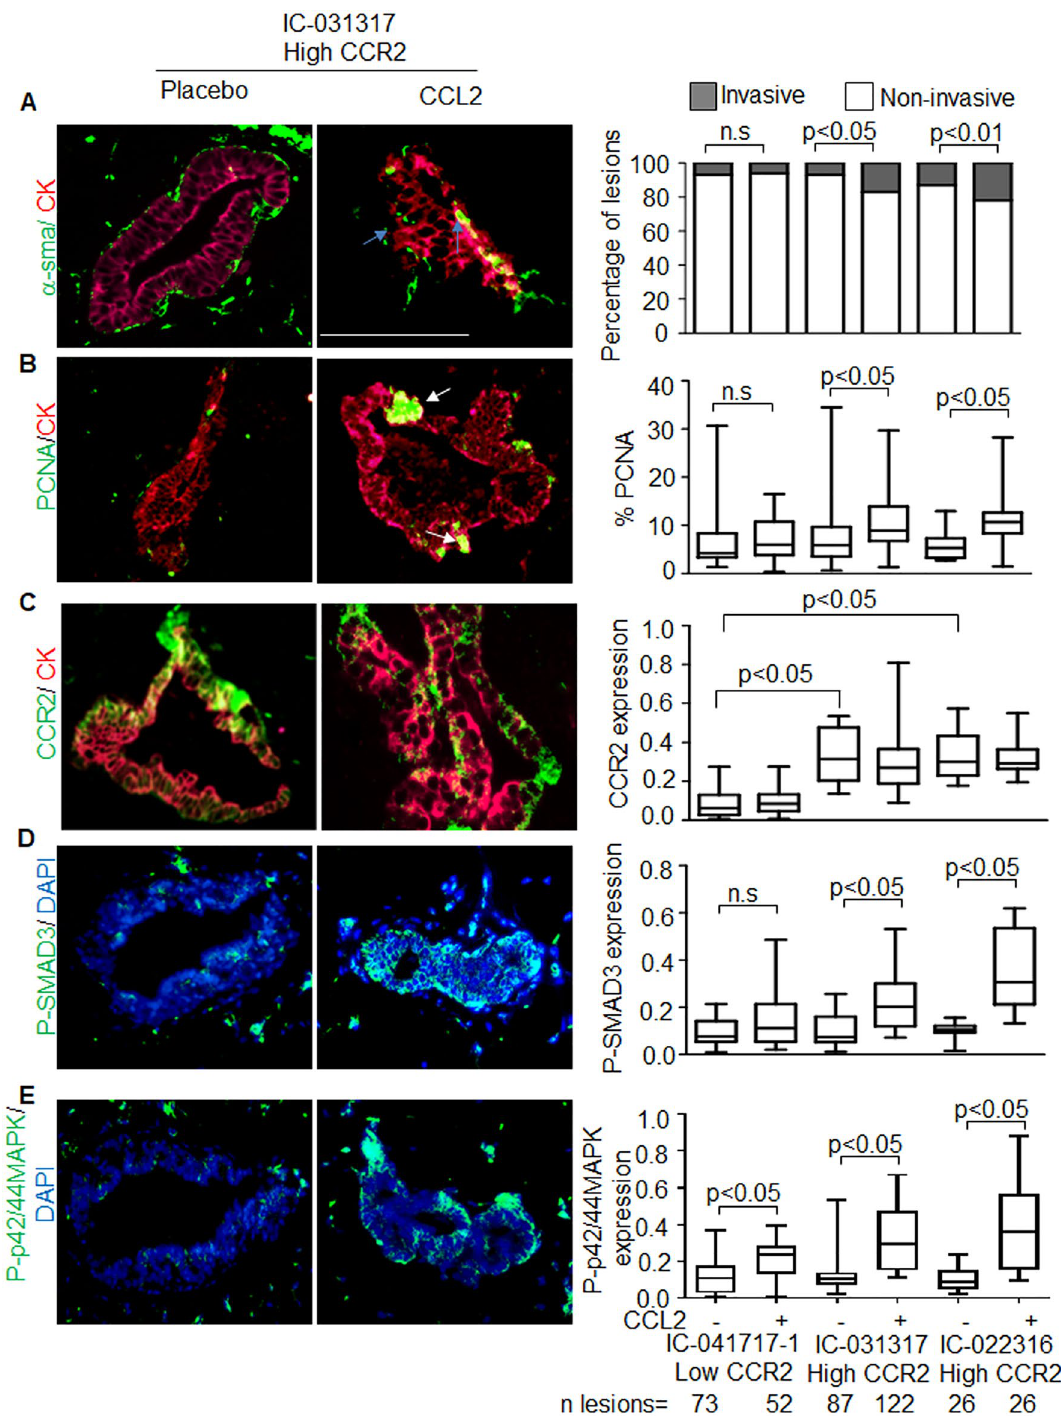
Figure 2. CCL2-mediated progression of patient derived breast xenografts is associated with increased CCR2, phospho-SMAD3 and phospho-p42/44MAPK expression. N = 4 mice (8 mammary fat pads total) were injected each with DCIS cells from patients IC-041717-1 and IC-031317. N = 2 mice (4 mammary fats total) were injected with DCIS cells from patient IC-022316. Mice were treated with placebo or recombinant CCL2 for up to 22 weeks. Primary breast xenografts were co-immunofluoresence stained for CK5/CK19 (red) with ( A ) α-sma, ( B ) PCNA, ( C ) CCR2, ( D ) phospho-SMAD3 (green) or E. phospho-p42/44MAPK (red). Sections were counter stained with DAPI. Representative images are shown for case no. IC-031317 with CK5/CK19 overlay with α-sma, PCNA or CCR2, and DAPI overlay with phospho-SMAD3 or phospho-p42/44MAPK expression. Blue arrows point to invasive carcinoma cells, characterized by absence of α-sma staining and presence of cancer cells in the peri-ductal stroma. White arrows point to positive PCNA staining. Scale bar = 200 microns. Sample size of mammary lesions per group are shown below the last graph. Invasiveness was scored for lesions co-stained for α-sma/CK5/19. Expression was quantified by Image J. Stacked bar graph is shown is shown for percentage of invasive and non-invasive lesions ( A ). Whisker box plots are shown for ( B – E ). Whiskers indicate min and max values. Box indicates upper and lower quartile range. Line indicates median. Statistical analysis was performed using Chi Square Test ( A ) or Two tailed T-test ( B – E ). Statistical significance analysis was determined by p < 0.05. ns not